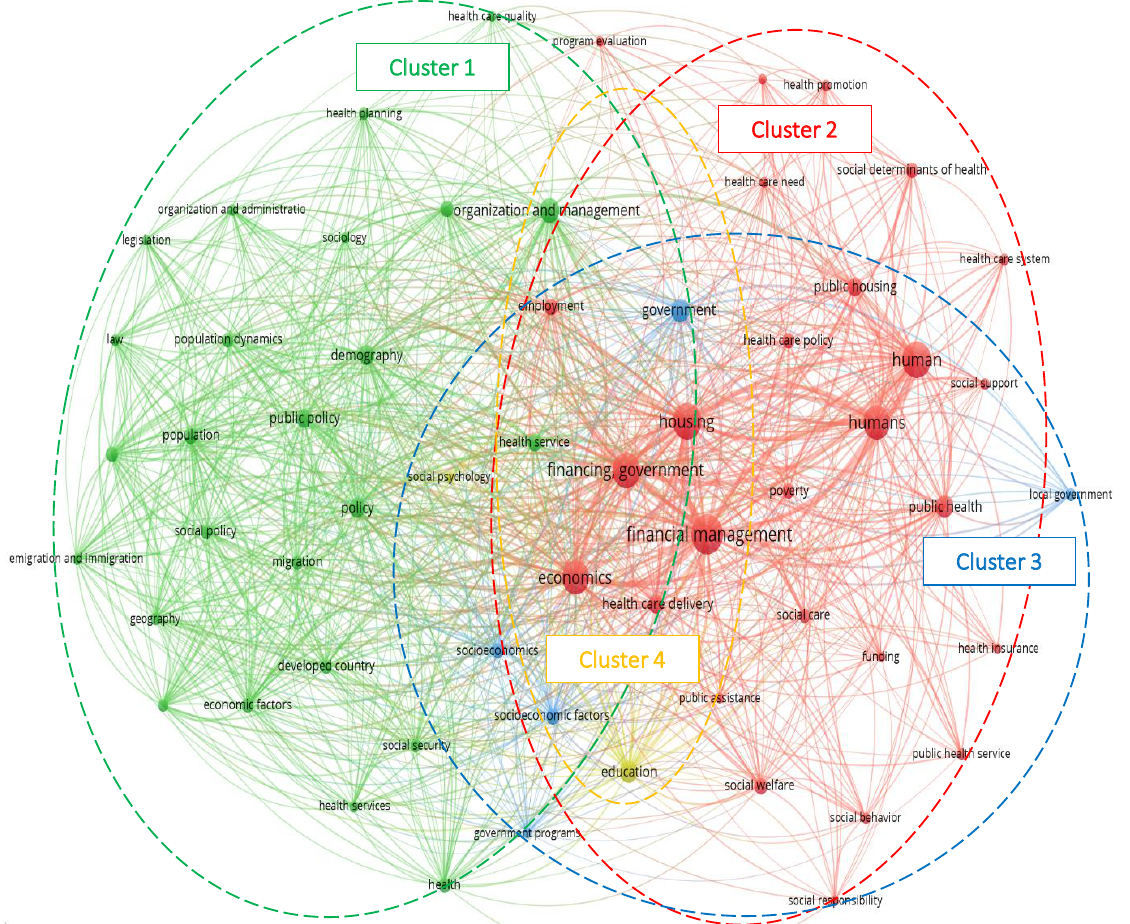
Figure 2. Clusters of scientific research that are the most closely related to the key request of